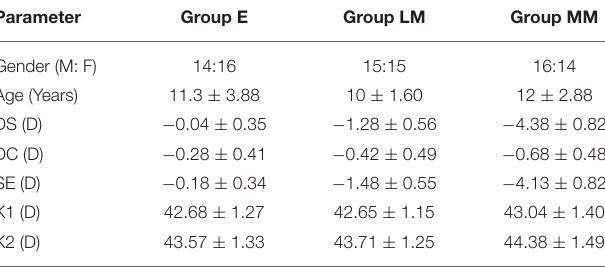
detect each part of retinal refractive values within 45 degrees with a low measurement